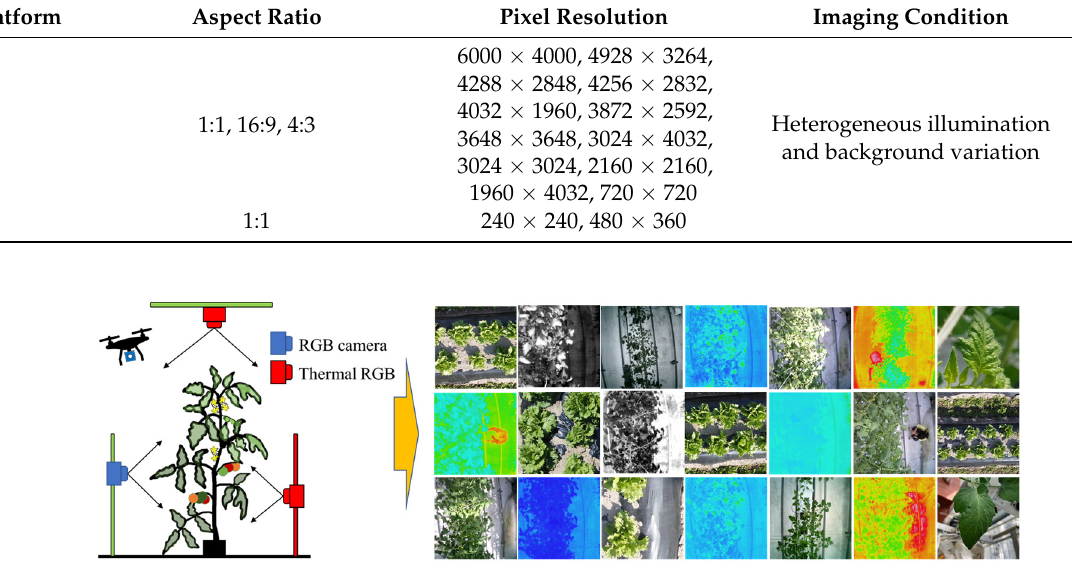
Figure 1. Diverse spatial patterns of input